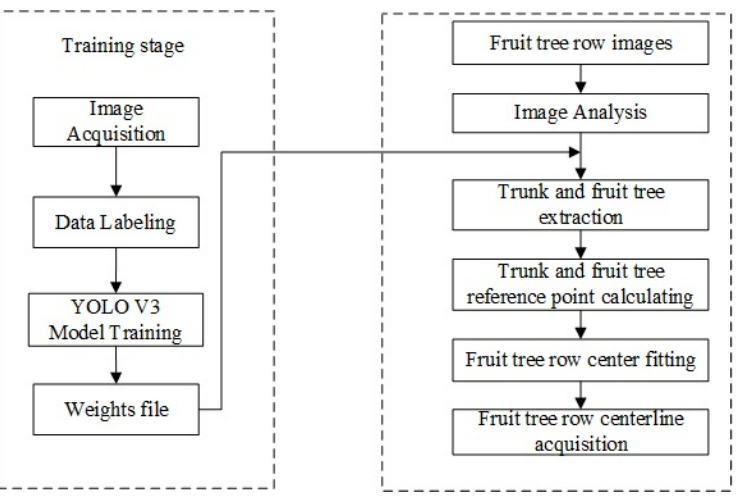
Figure 2. Flowchart of the deep-learning extraction method of orchard visual navigation line.